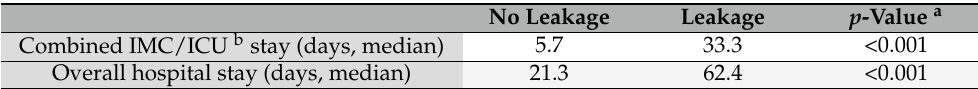
Table 3. Effects of intrathoracic anastomotic leakage on combined IMCU/ICU and overall hospital stay in